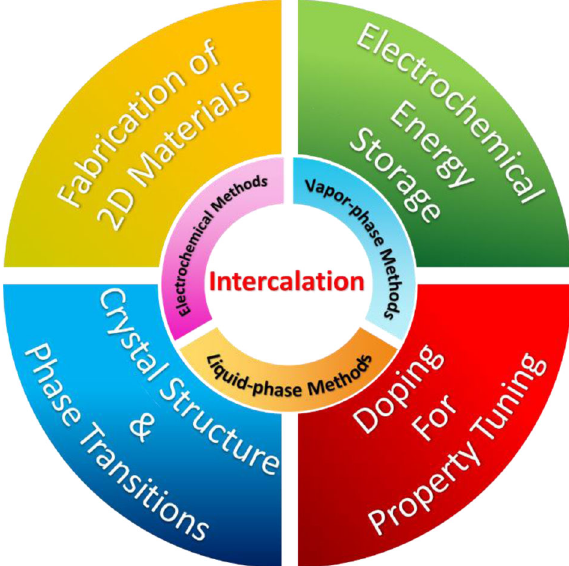
Fig. 1 Intercalation of 2D materials. Schematic diagram summariz- ing different intercalation techniques and applications of intercala- tion in 2D